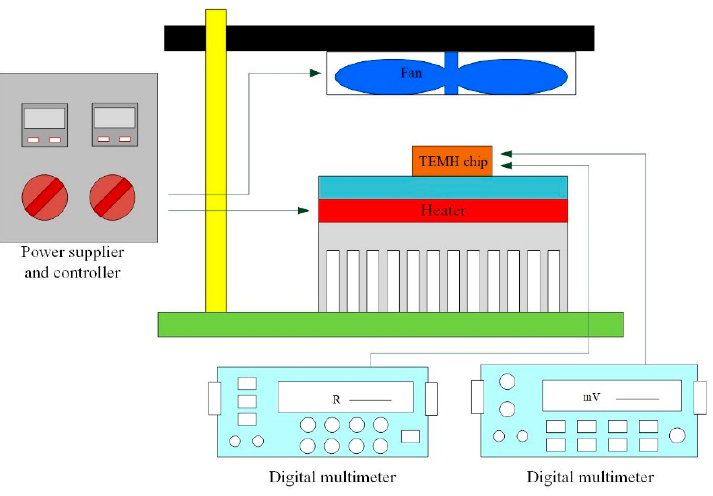
Figure 16. Measurement setup for the TEMH.